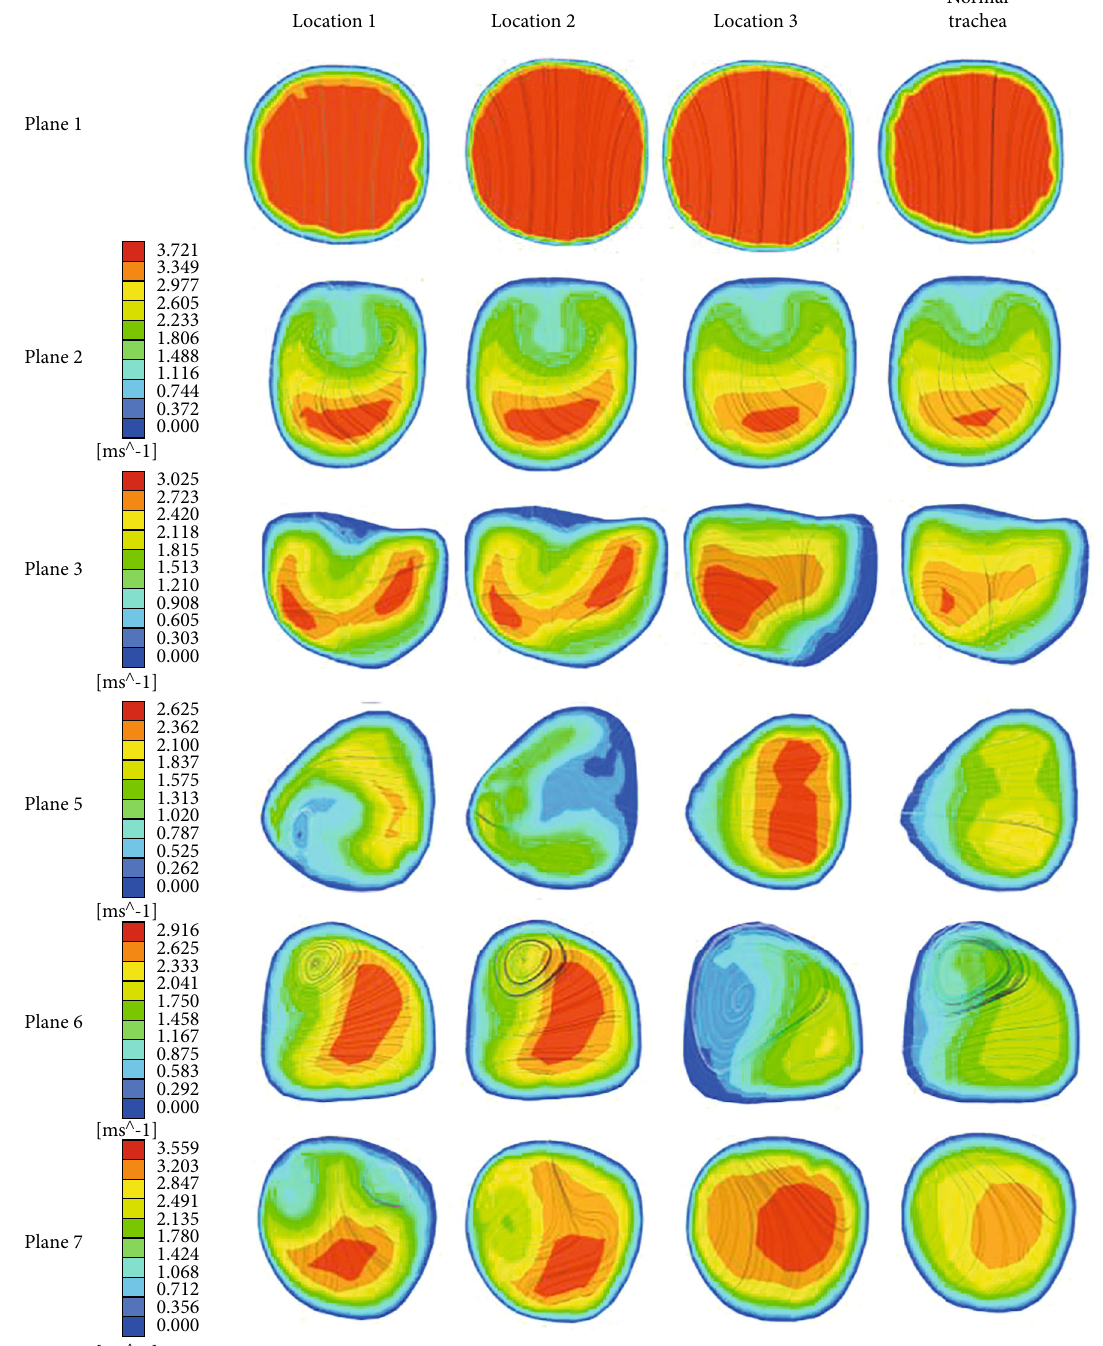
Figure 7: Velocity contours at di ff erent positions of the healthy airway and foreign bodies of di ff erent